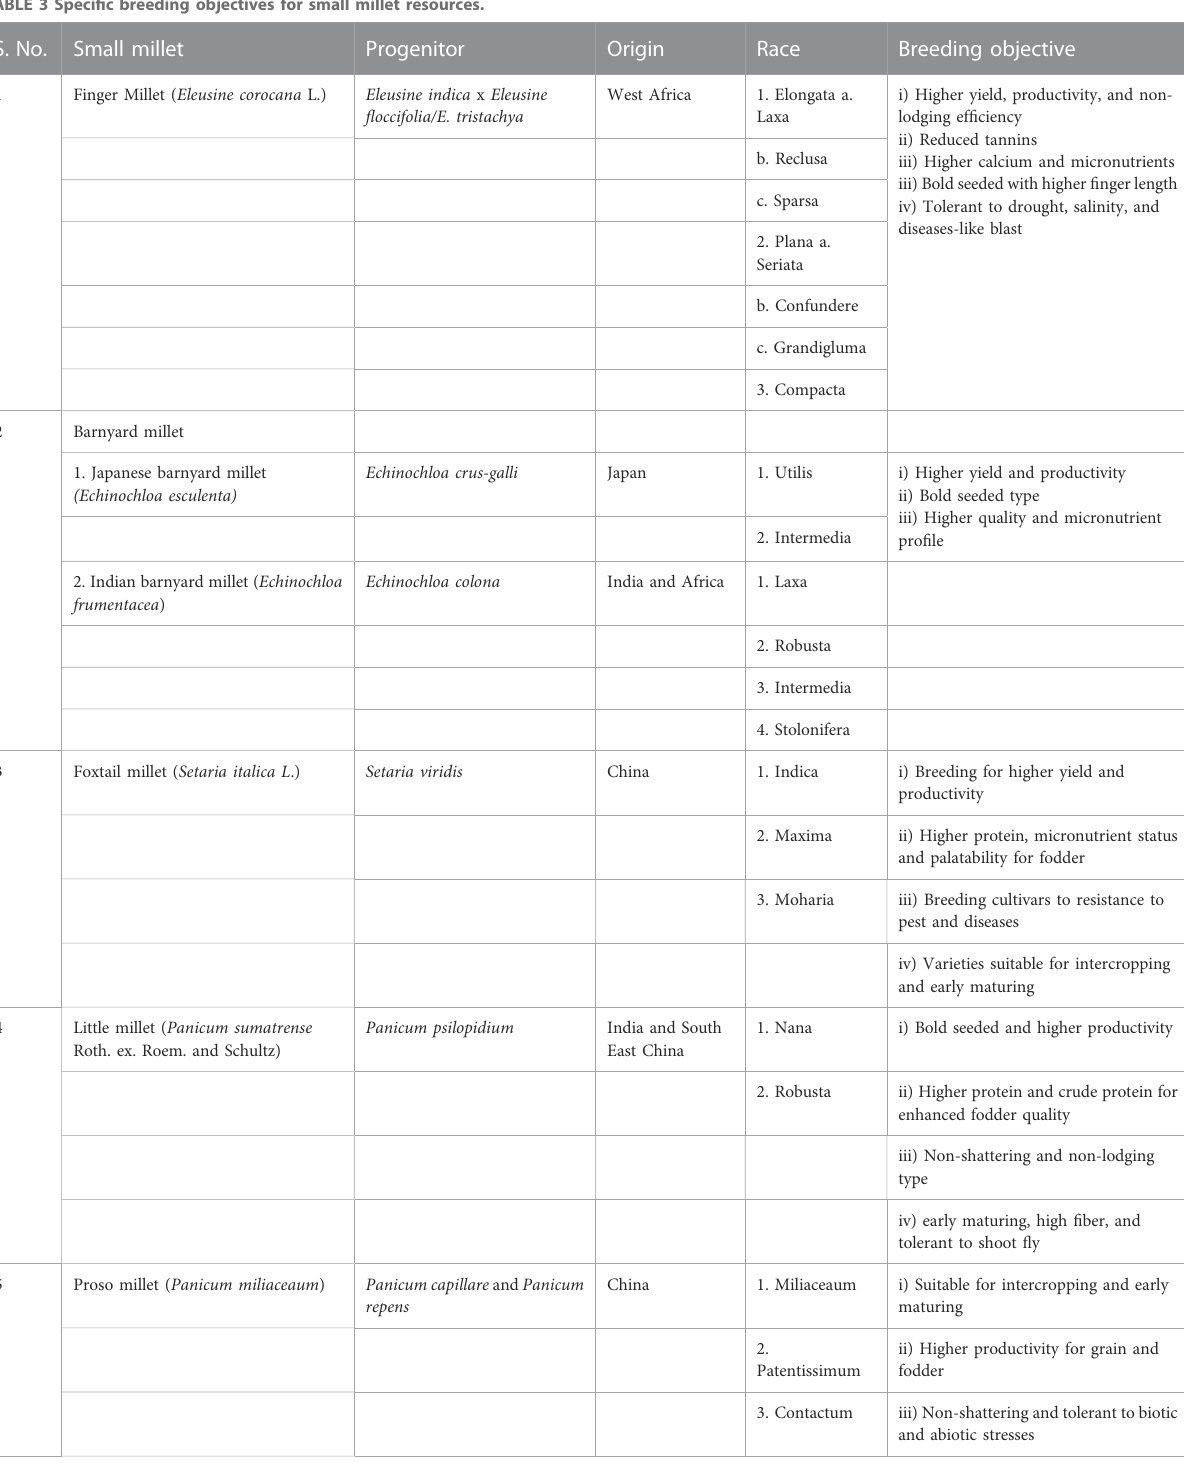
TABLE 3 Speci fi c breeding objectives for small millet resources. S. No. Finger Millet ( Eleusine corocana